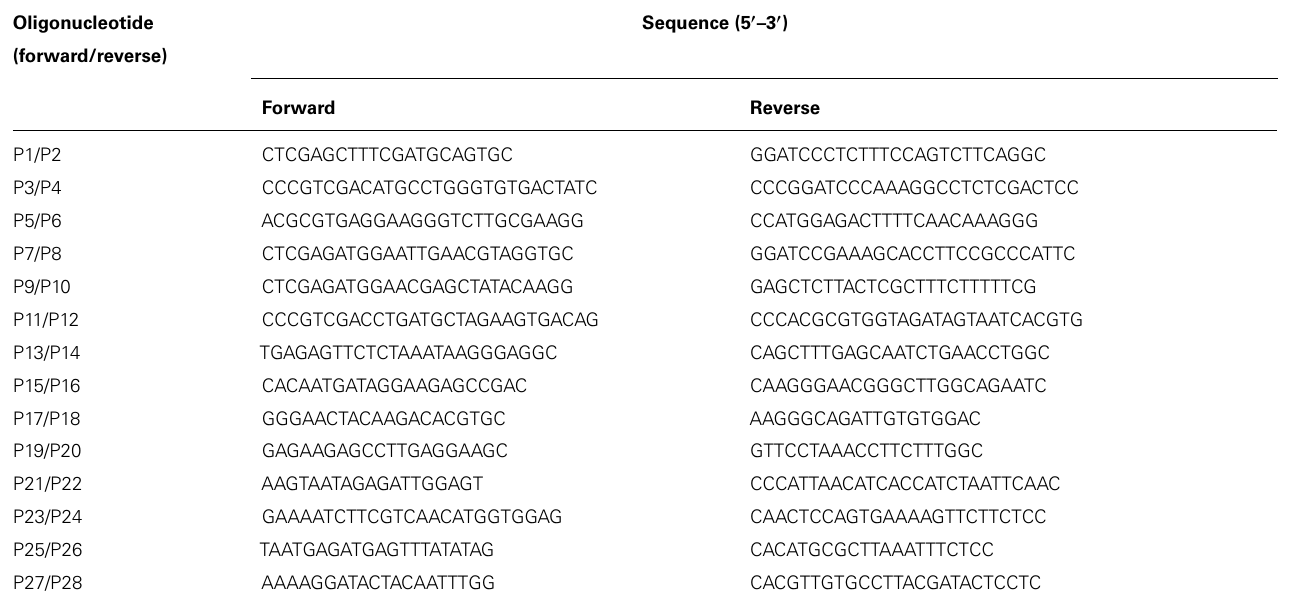
Table 1 | Primer pairs used for PCR.